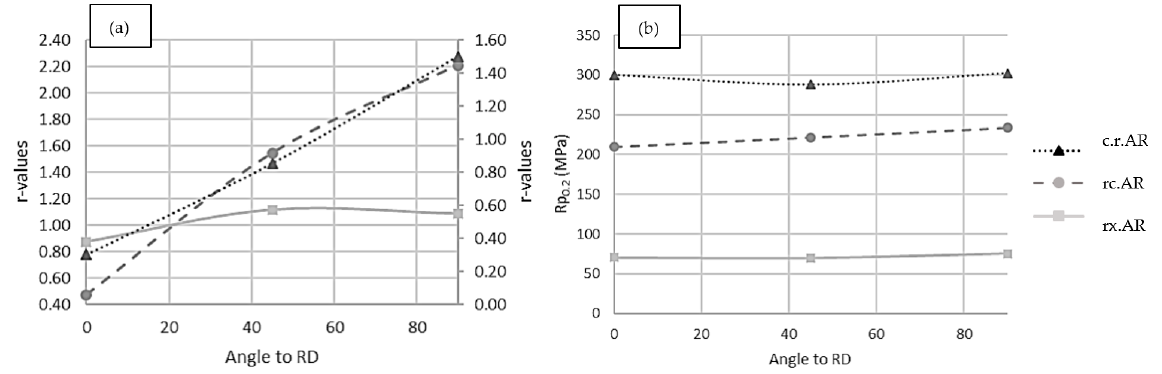
Figure 5. ( a ) Plastic strain ratio (r value) of examined sheet samples, ( b ) in ‐ plane anisotropy in a yield strength, Rp 0.2 .